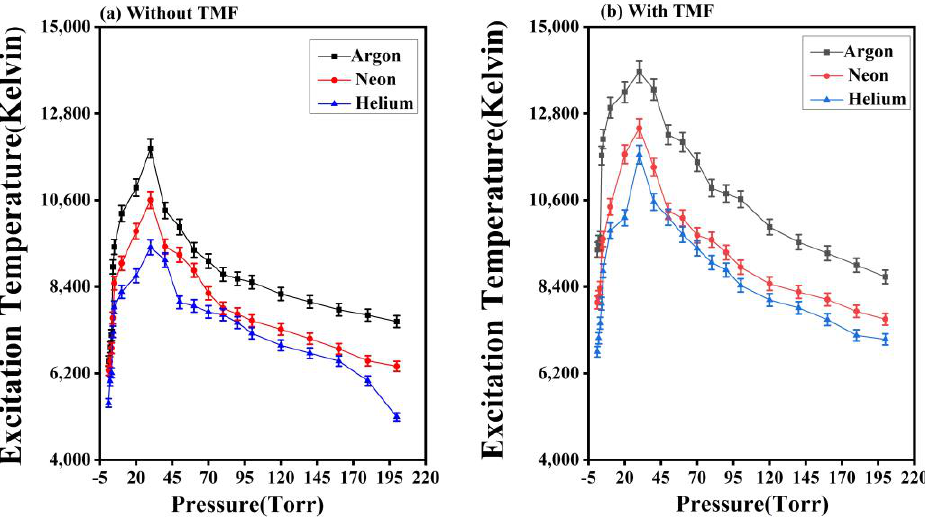
Figure 5. The change in Te of laser-induced Cu-alloy plasma at different pressures in Ar, Ne, and He environments at 3.8 GW/cm 2 ns laser irradiance in the absence ( a ) and presence ( b ) of TMF. The Te of the LPP of Cu-alloy ranges from 6513 K to 11,915 K for Ar, 6278 K to 10,605 K for Ne, and 5449 K to 9404 K for He in the absence of TMF. Ar has Te values between 8653